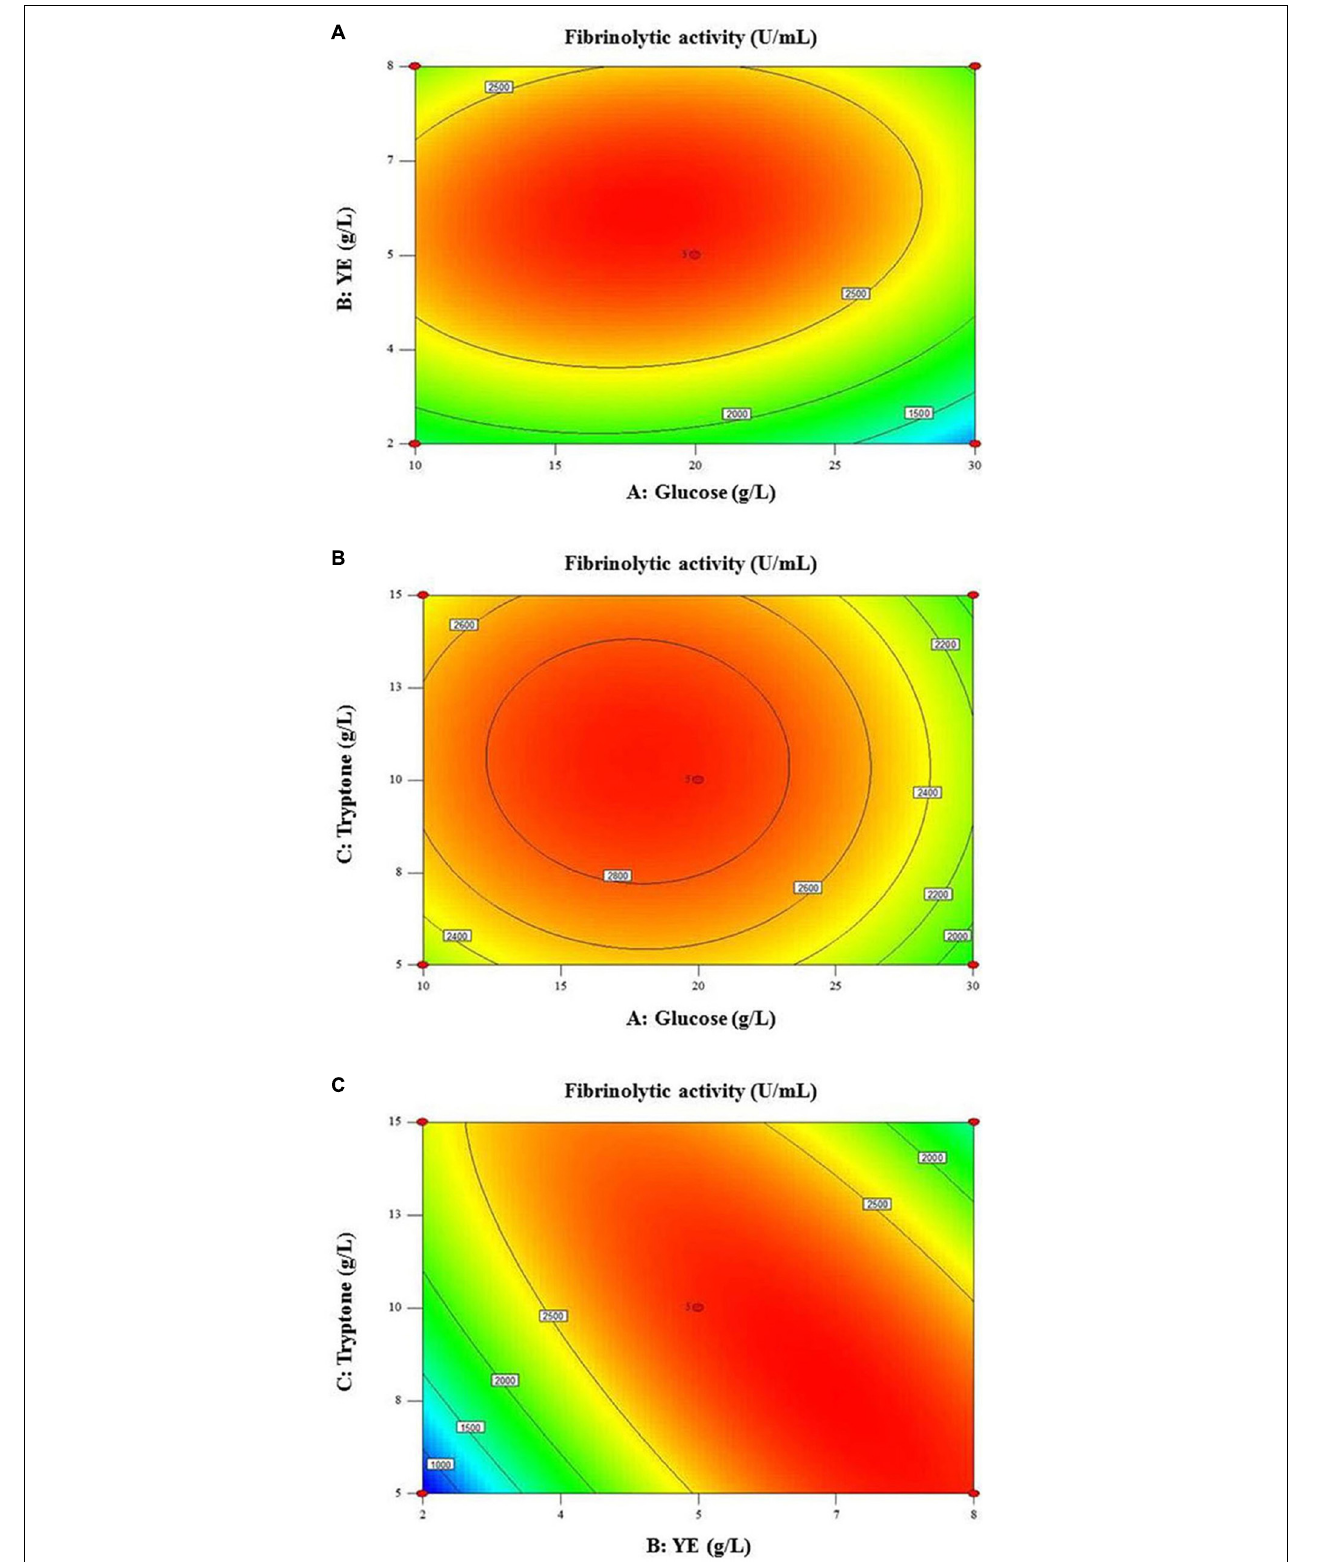
FIGURE 5 | Contour plots showing interactive effects of (A) glucose and YE, (B) glucose and tryptone and (C) YE and tryptone on fibrinolytic activity.